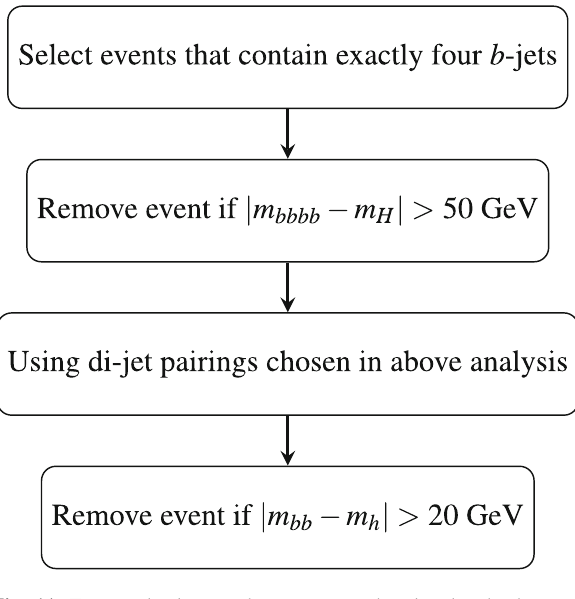
Fig. 11 Event selection used to compute the signal-to-background rates